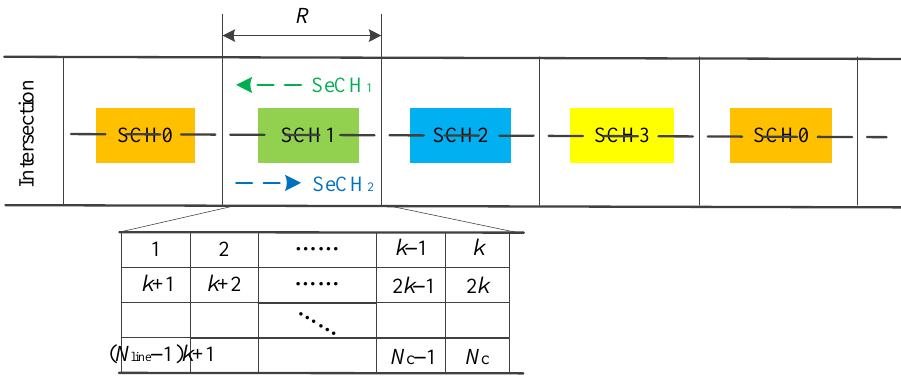
Figure 12. Road Figure 12. Road segmentation.